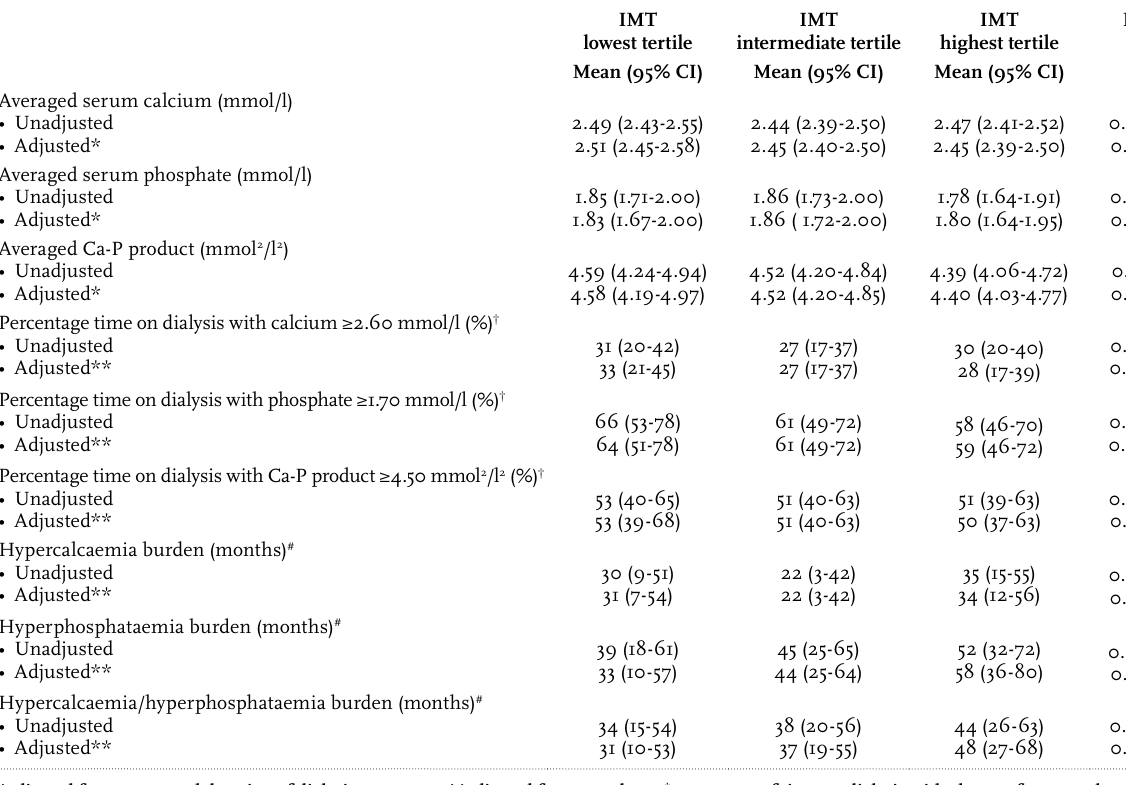
table 3. Calcium and phosphate parameters for different categories of